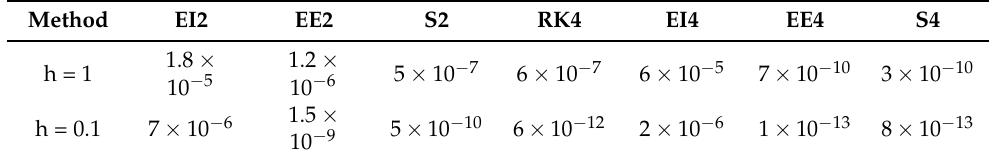
Table 1. Computational accuracy of different algorithms. Largest absolute values of Hamiltonian errors correspond to time step h . Orbit 1 is integrated until proper time τ = 10 8